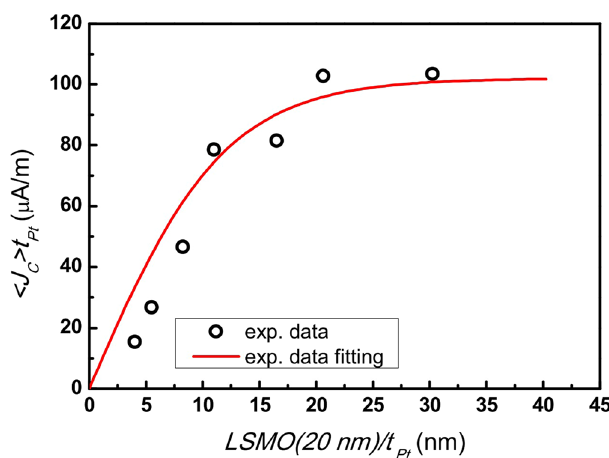
Figure 6. Spin current density j respective damping constants being shown in the inset.